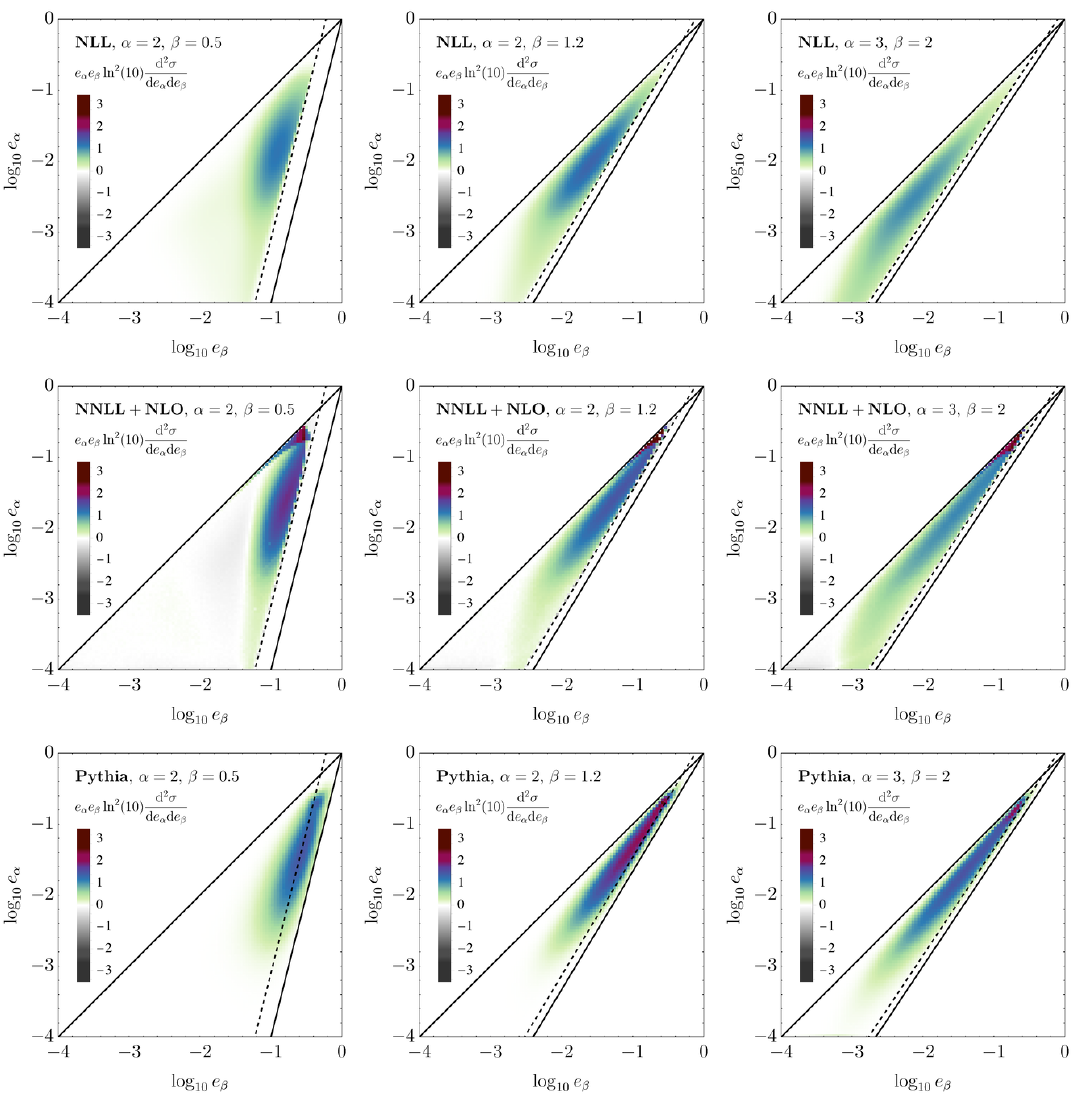
Figure 11 . The NLL (top), NNLL+NLO (middle) and Pythia (bottom) cross section for three pairs of angularities ( (cid:11); (cid:12) ) = (2 ; 0 : 5) (left), (2, 1.2) (middle) and (3,2)